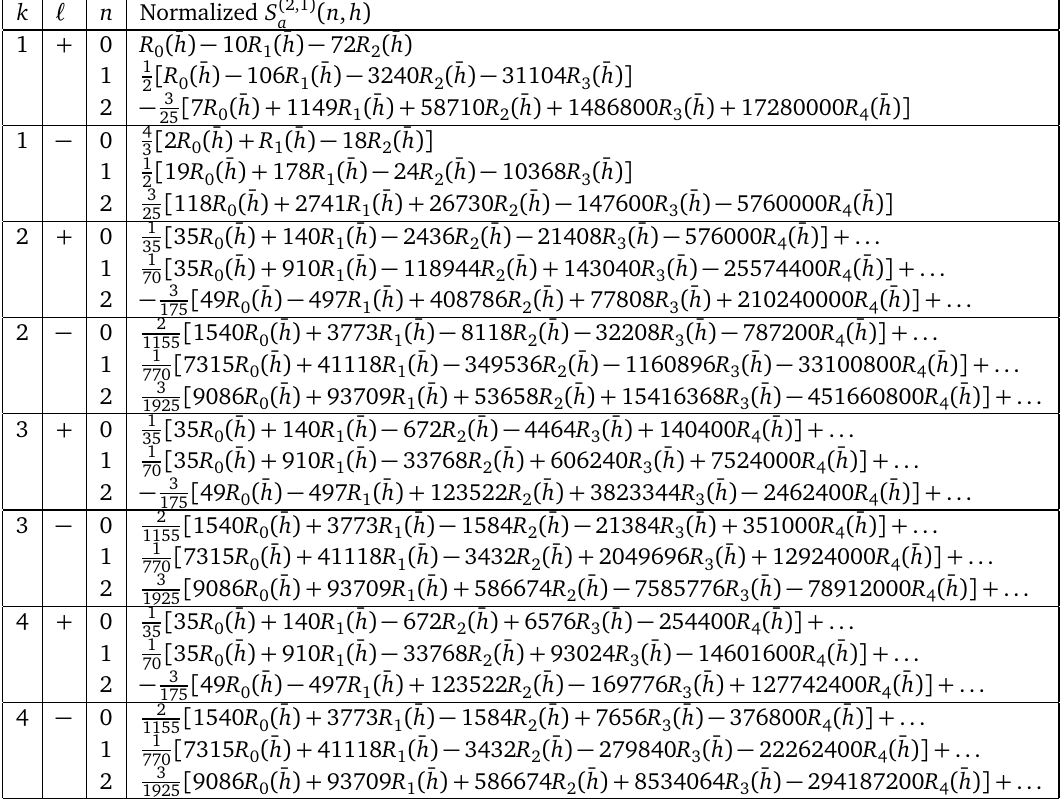
∨ ( F ) 1 ] 2 ( n ,¯ h ) / [ 24 G t F a which is the coefficient of the double a 2 | G F | ( F t ) 0 a